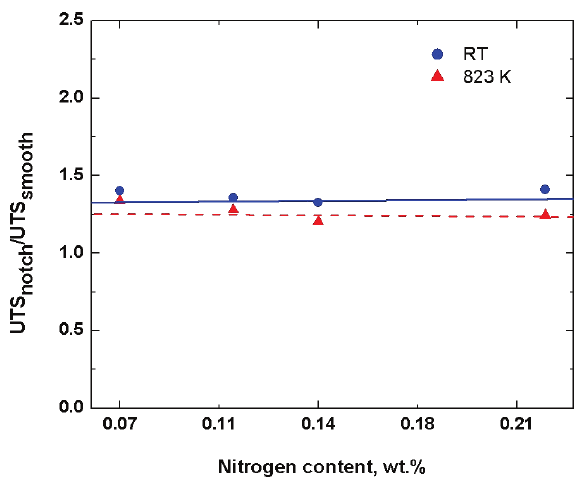
Figure 6. Influence of nitrogen on the ratio of ultimate ten- sile strength of notched to smooth specimens at room tem- perature and 823 K.